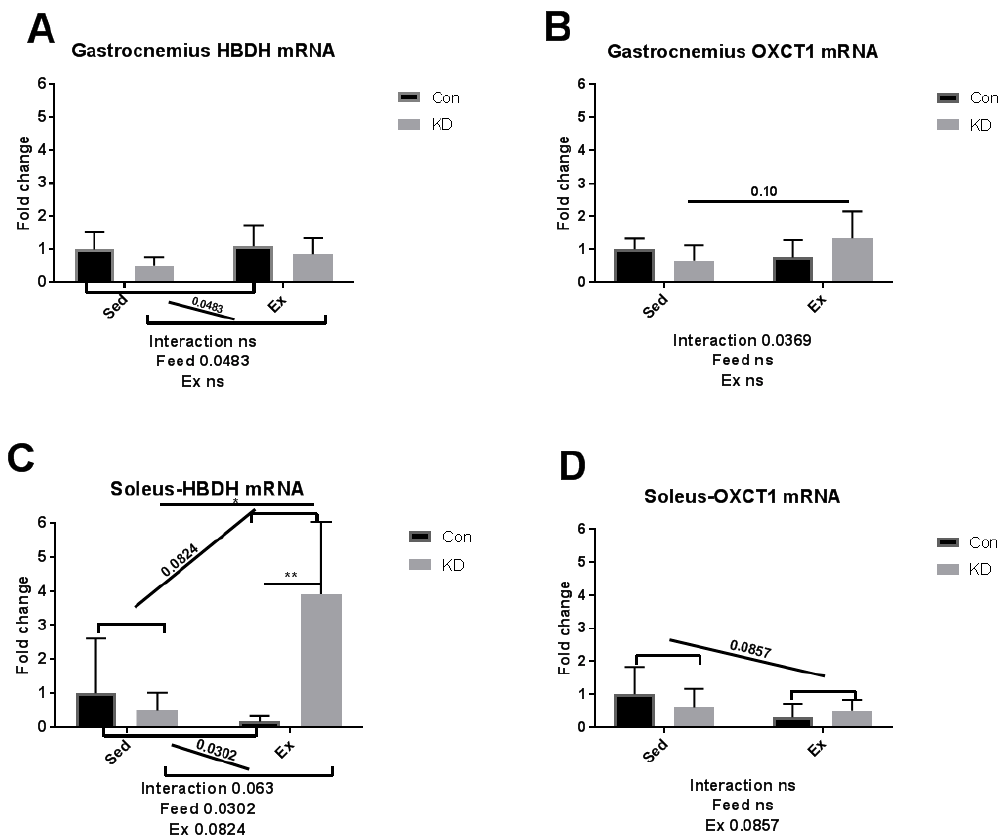
Figure 4. mRNA expression of ketolytic rate-limiting enzyme immediately after exhaustion in gastrocnemius ( A , B ) and soleus ( C , D ). HBDH: hydroxybutyrate dehydrogenase. OXCT-1: 3-oxoacid CoA-transferase. ns: no significance observed. * p < 0.05 and ** p < 0.01. Significance between groups are marked using slashes.